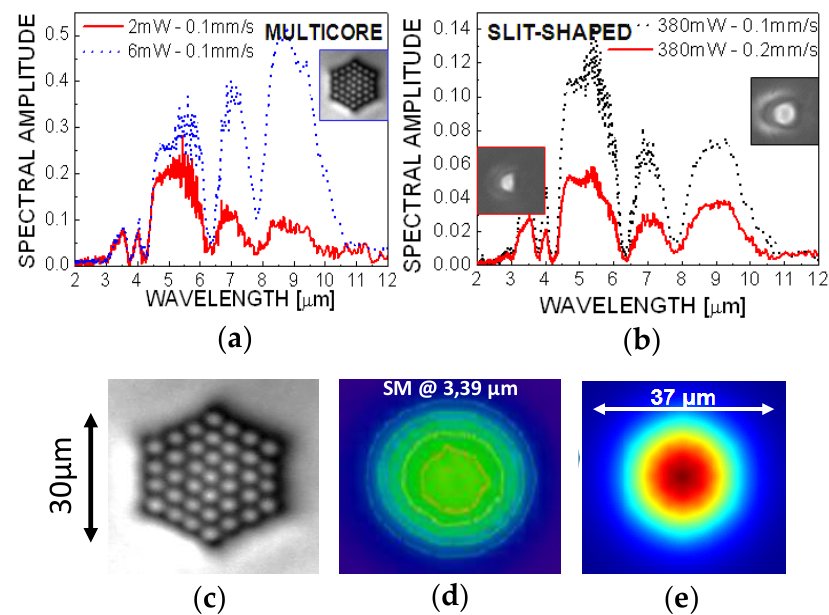
Figure 4. ( a ) MIR large band guiding in a multicore waveguide. The spectral dependencies of the laser-induced structures as a function of the index contrast is also shown. Two input powers at 2 and 6 mW are used with the same sample scan velocities of 0.1 mm/s, in order to obtain two different index contrasts. Higher contrast leads to better guiding in the large wavelength spectral domain; ( b ) Laser energy dose dependent spectral behavior of slit-shaped traces via two scan velocities (0.1 and 0.2 mm/s) at the same input power of 380 mW. Higher contrast leads to better guide transparency; however, overall performances lay below those of the multicore; ( c ) Multicore structure written in bulk Ge 15 As 15 S 70 glass (10 mm length) at 2.4 mW, 100 kHz input laser conditions via a NA 0.5 aspherical lens at 0.5 mm/s scan speed. The inter-trace spacing is 5 µm, and the whole diameter 30 µm; ( d ) The corresponding single mode guided at 3.39 µm, detected via a FLIR camera [9]; (e) Finite element analysis for a guided mode at 3.39 µm in a multicore hexagonal structure with 5 µm spaced, 4 µm thick individual traces of NA = 0.08.